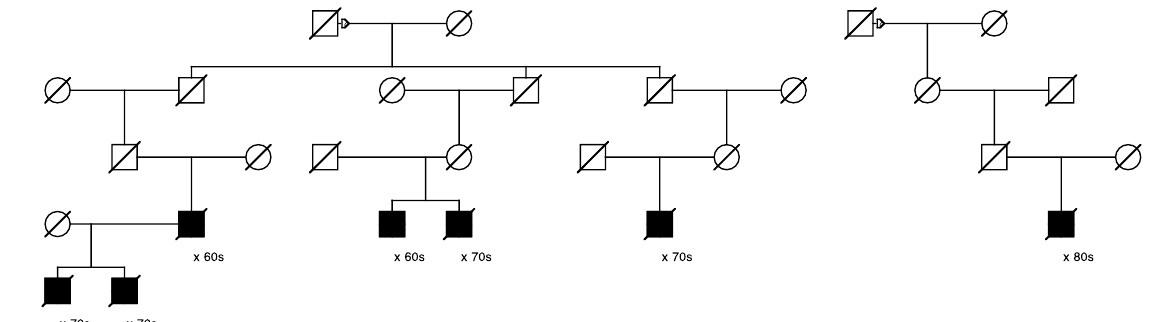
Figure 4. High-risk prostate cancer pedigree segregating the rare pathogenic MUTYH variant.